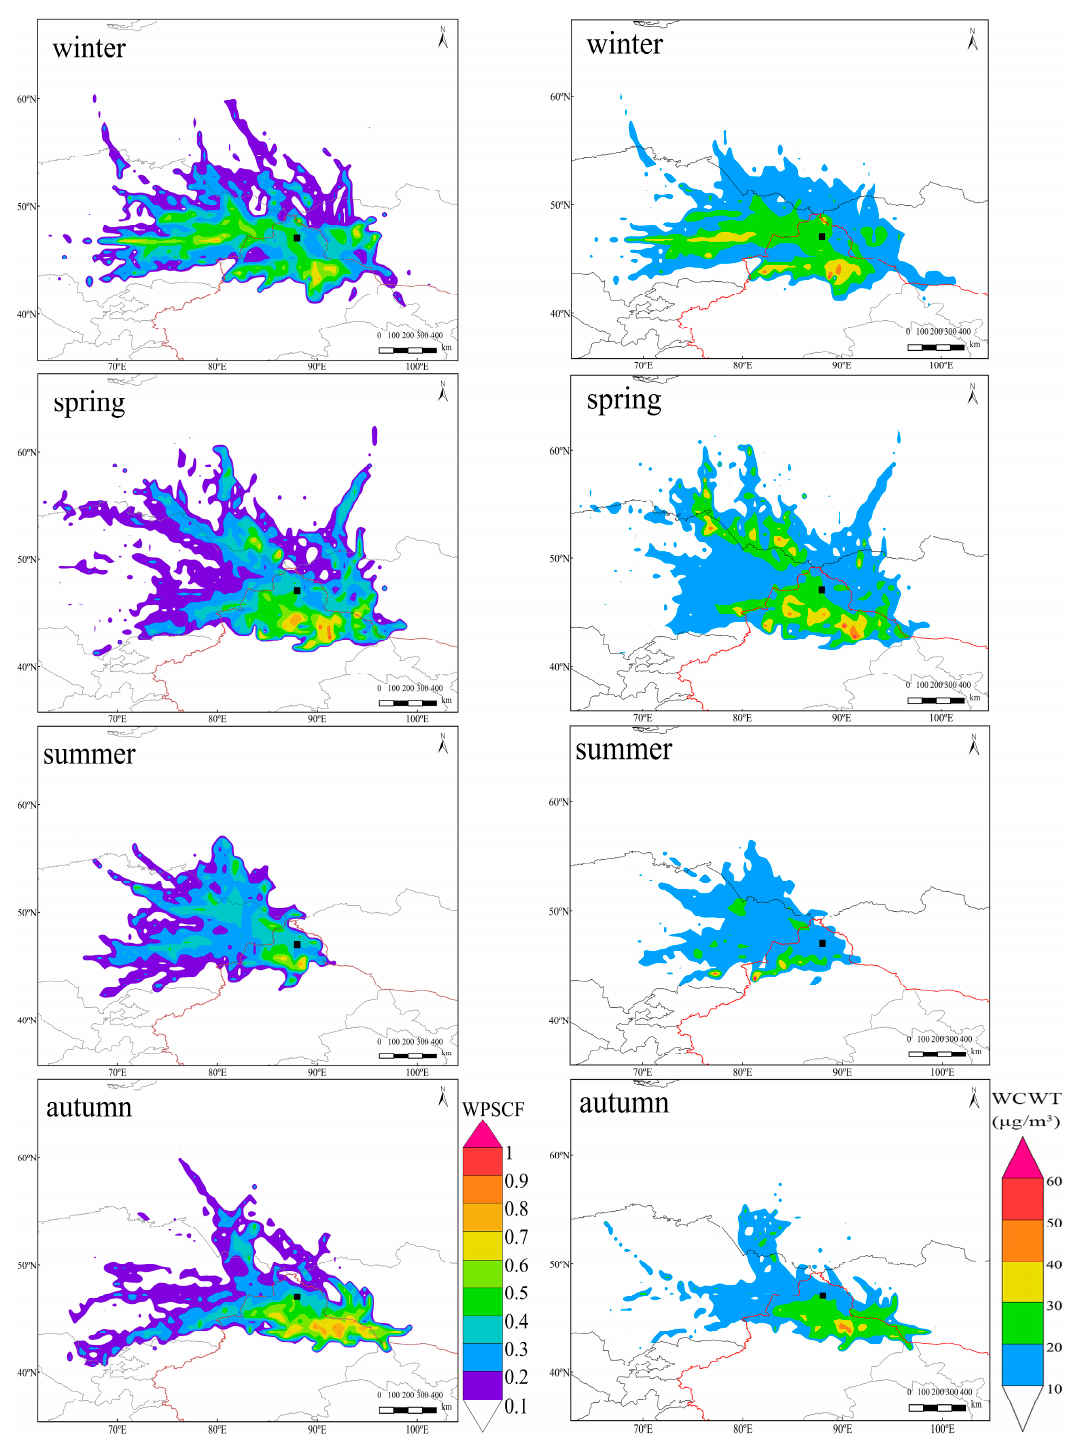
Figure 7. WPSCF and WCWT maps of PM 10 in winter, spring, summer, and autumn from January 2017 to December 2019. The black square represents Akedala. WPSCF: Weighted Potential Source Contribution Function. WCWT: Weighted Concentration-Weight Trajectory.